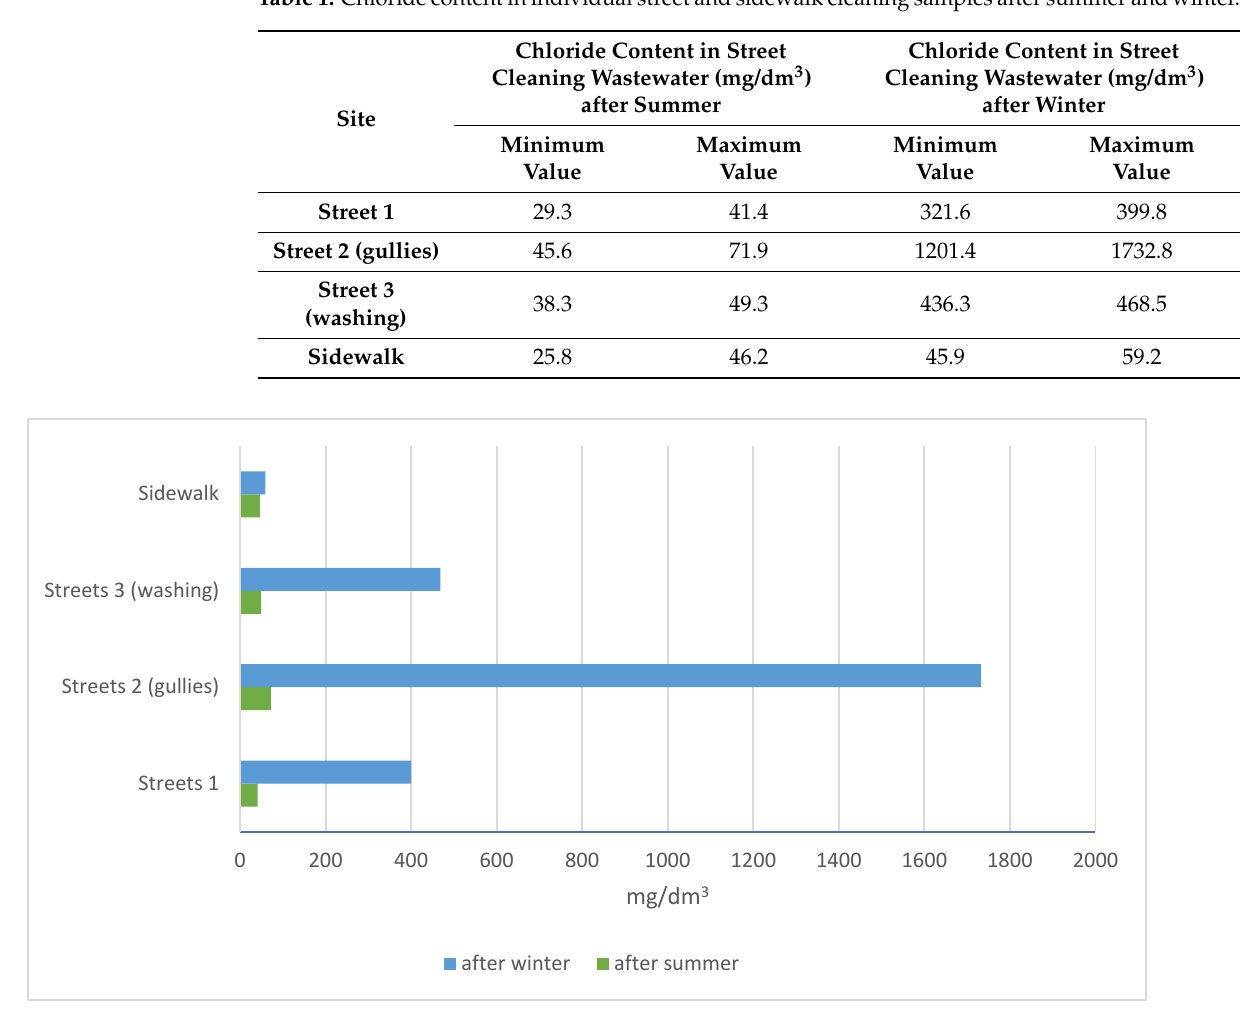
Table 1. Chloride content in individual street and sidewalk cleaning samples after summer and winter.